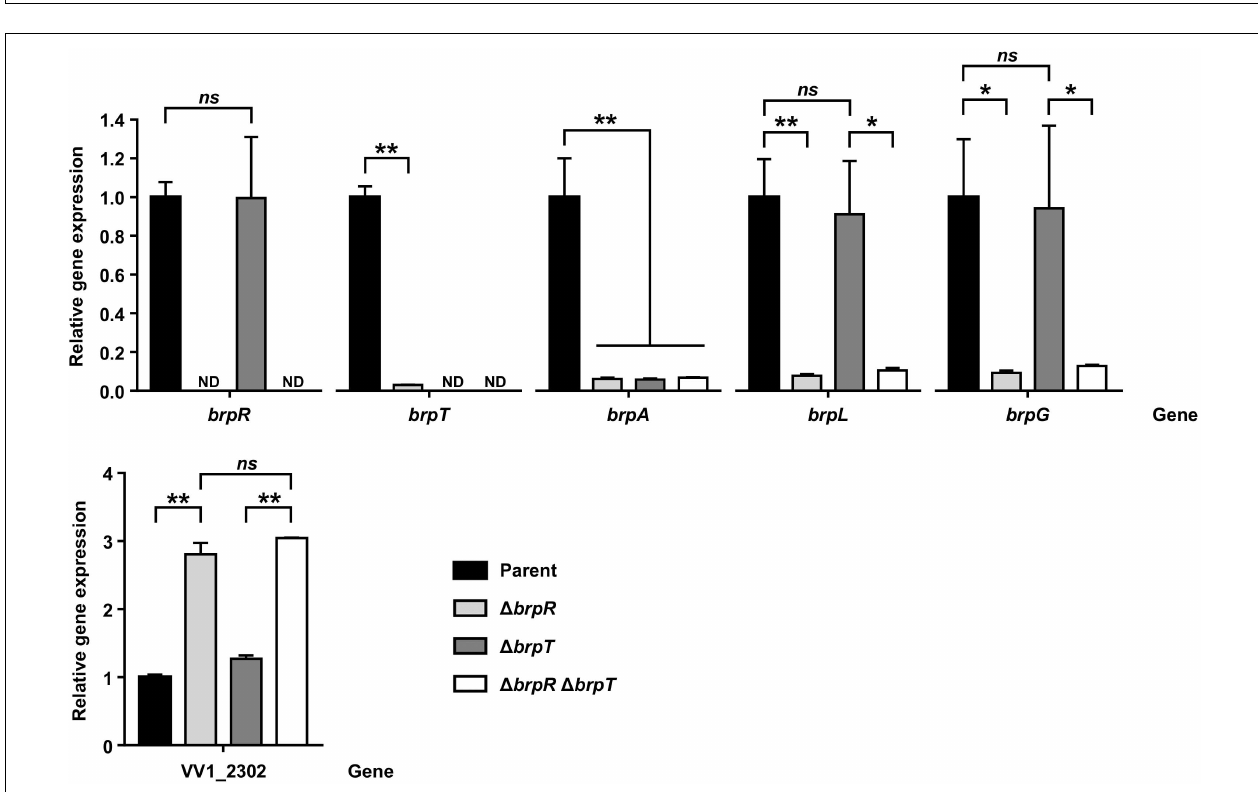
FIGURE 4 | Effects of BrpR and BrpT on the expression of downstream genes. Total RNAs were isolated from the parent and mutant strains grown to an A 600 of 2.0 with 0.01% arabinose. The brpR , brpT , brpA , brpL , brpG , and VV1_2302 expression was determined by qRT-PCR analysis, and the expression of each gene in the parent strain was set at 1. ND, not detected. Parent, parent strain; (cid:49) brpR , (cid:49) brpR mutant; (cid:49) brpT , (cid:49) brpT mutant; (cid:49) brpR (cid:49) brpT , (cid:49) brpR (cid:49) brpT double mutant. Error bars represent the SD. Statistical significance was determined by the Student’s t test (**, P < 0.005; *, P < 0.05; ns , not